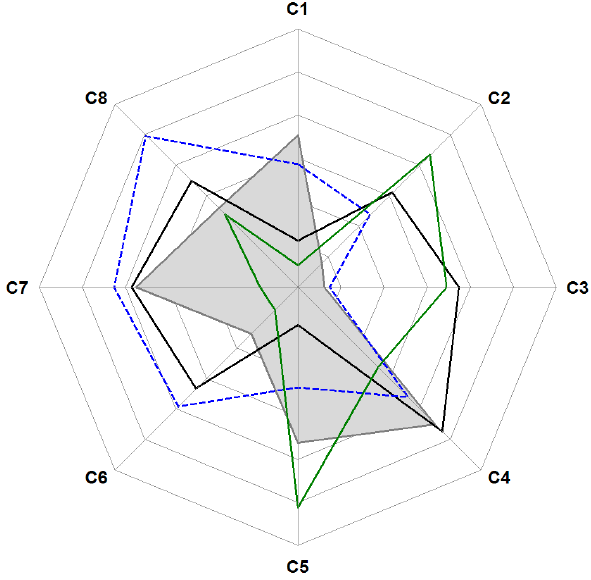
Figure 3. Spider diagram representing four alternatives and eight criteria (source: